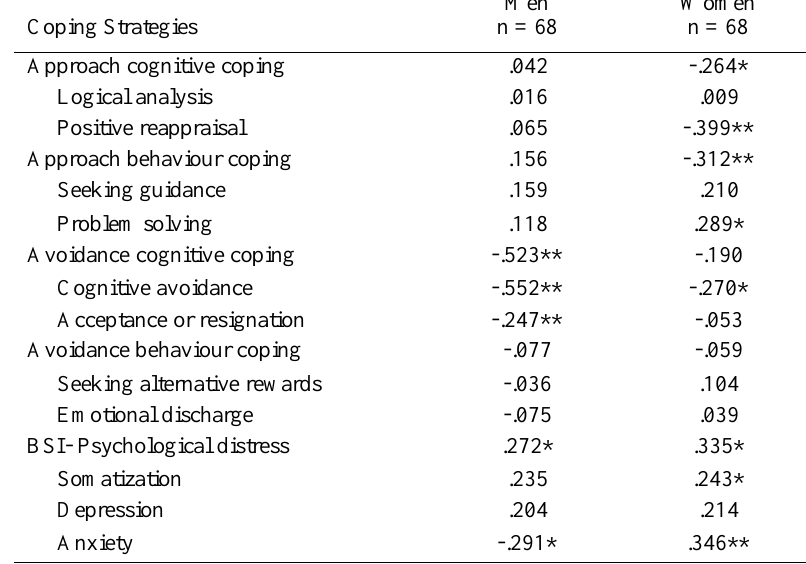
Men Women n = 68 n = 68